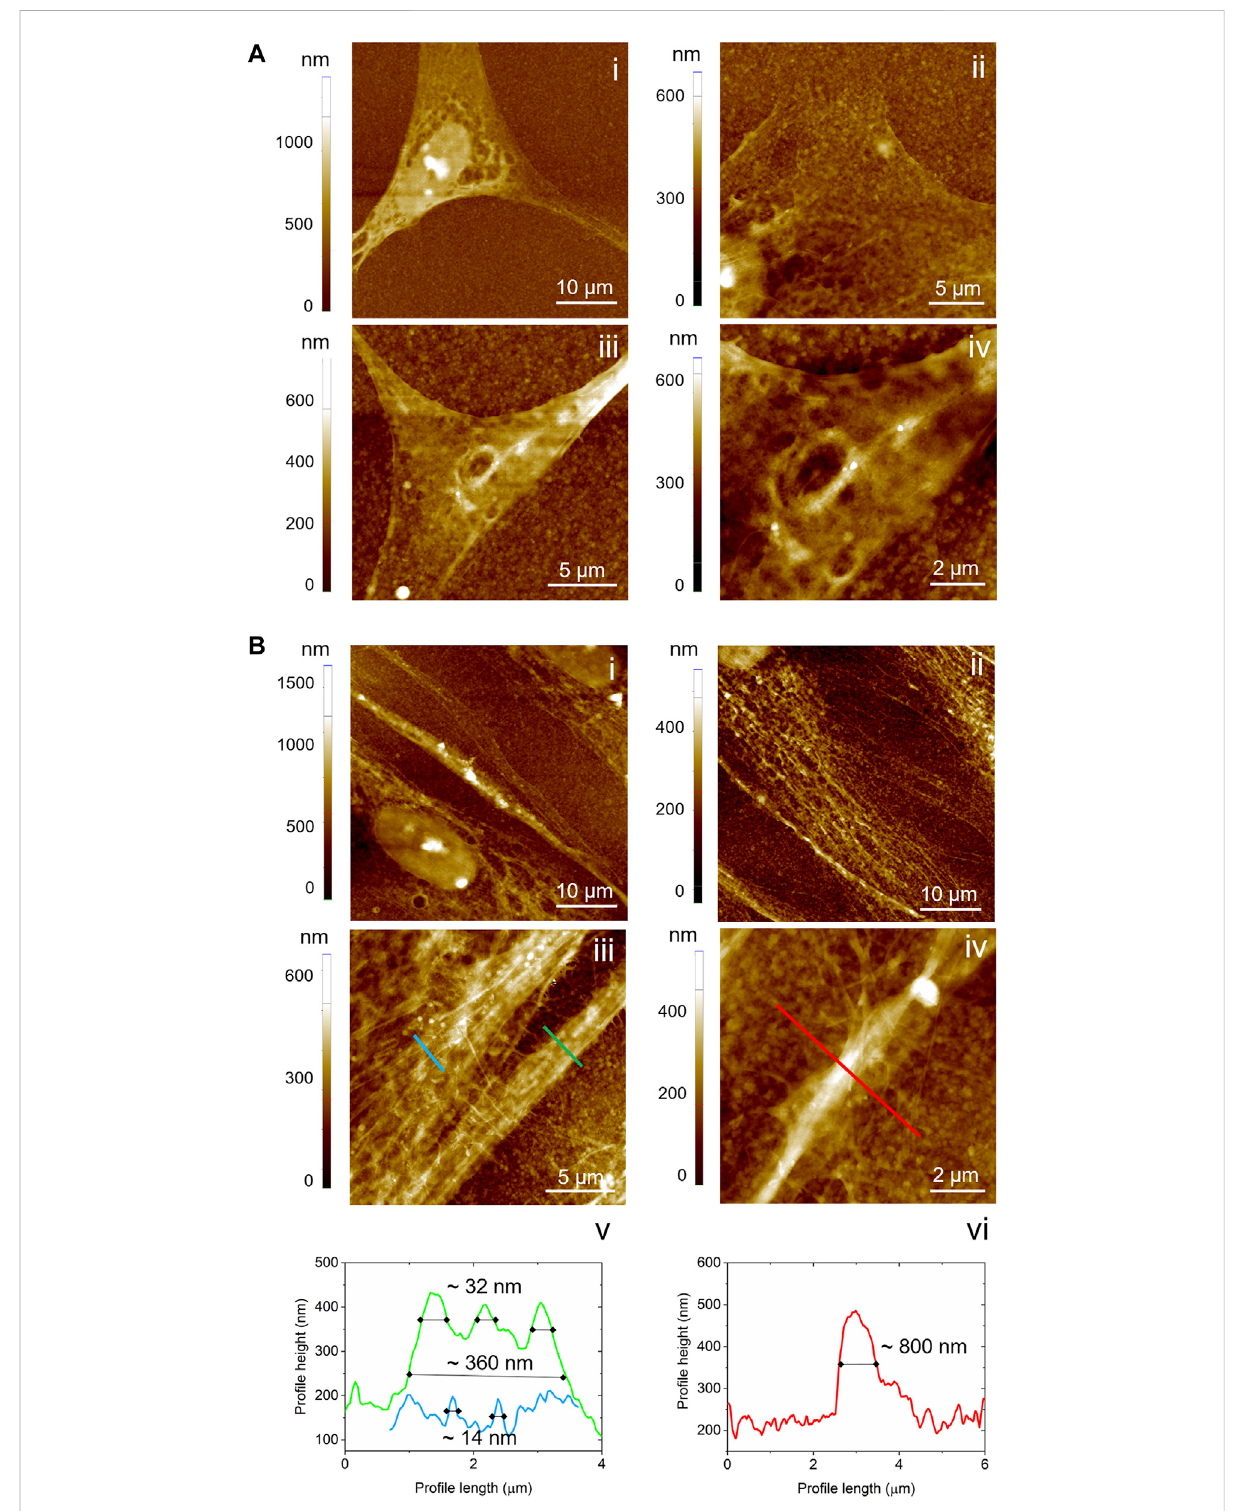
AFM analysis of cell morphology at the micro- and nanoscale. Topography images acquired on hDPSCs cultured on ED-PEDOT (A) before and (B) after 7 days of differentiation. In panels b, v and b, vi, the pro fi le lines corresponding to the lines in b, iii and b, iv, are